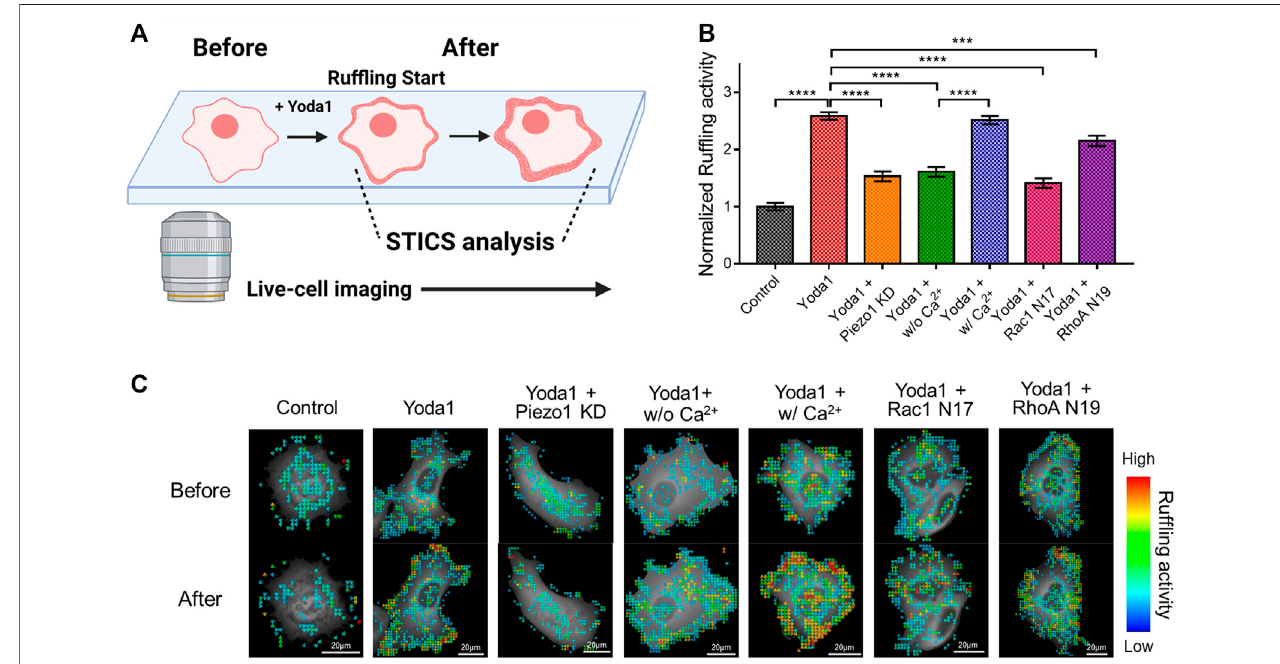
FIGURE 8 | Effects of Piezo1-induced extracellular calcium in fl ux on membrane ruf fl ing. (A) A schematic illustration explaining the procedure for analyzing the membraneruf fl ing withSTICS. Live-cellimagingwasused tovisualize membrane ruf fl ing, which occurs brie fl yafter Yoda1 treatment,and STICS analyzed thevideos, or a series of images, showing the movement. The illustration was created using BioRender (https://biorenders.com/) (B) The bar graph describes the mean values of the normalized ruf fl ing activity with error bars indicating the S.E.M (the number of analyzed particles = 108, *** p < 0.001 and **** p < 0.0001, Student ’ s t -test). The cells weretreated withthecontrol[0.2% (v/v) DMSO]and Yoda1 (1 μ M) dissolved inCO 2 -independentculturemedium(Yoda1group),Ca 2+ -freemedium (Yoda1+w/o Ca 2+ group), and Ca 2+ medium (Yoda1 + w/Ca 2+ group), respectively. The Yoda1 + Piezo1 KD, Rac1 N17, and RhoA N19 groups were incubated in a CO 2 -independent culturemedium. (C) The fl owmappingimagesrepresentthevelocityoftheGFP-cortactinparticlesexpressedinMCF-7cells.Thecolorscalebarsrepresenttherangeof the ruf fl ing activity calculated by STICS. Hot and cold colors indicate high and low ruf fl ing activity, respectively.